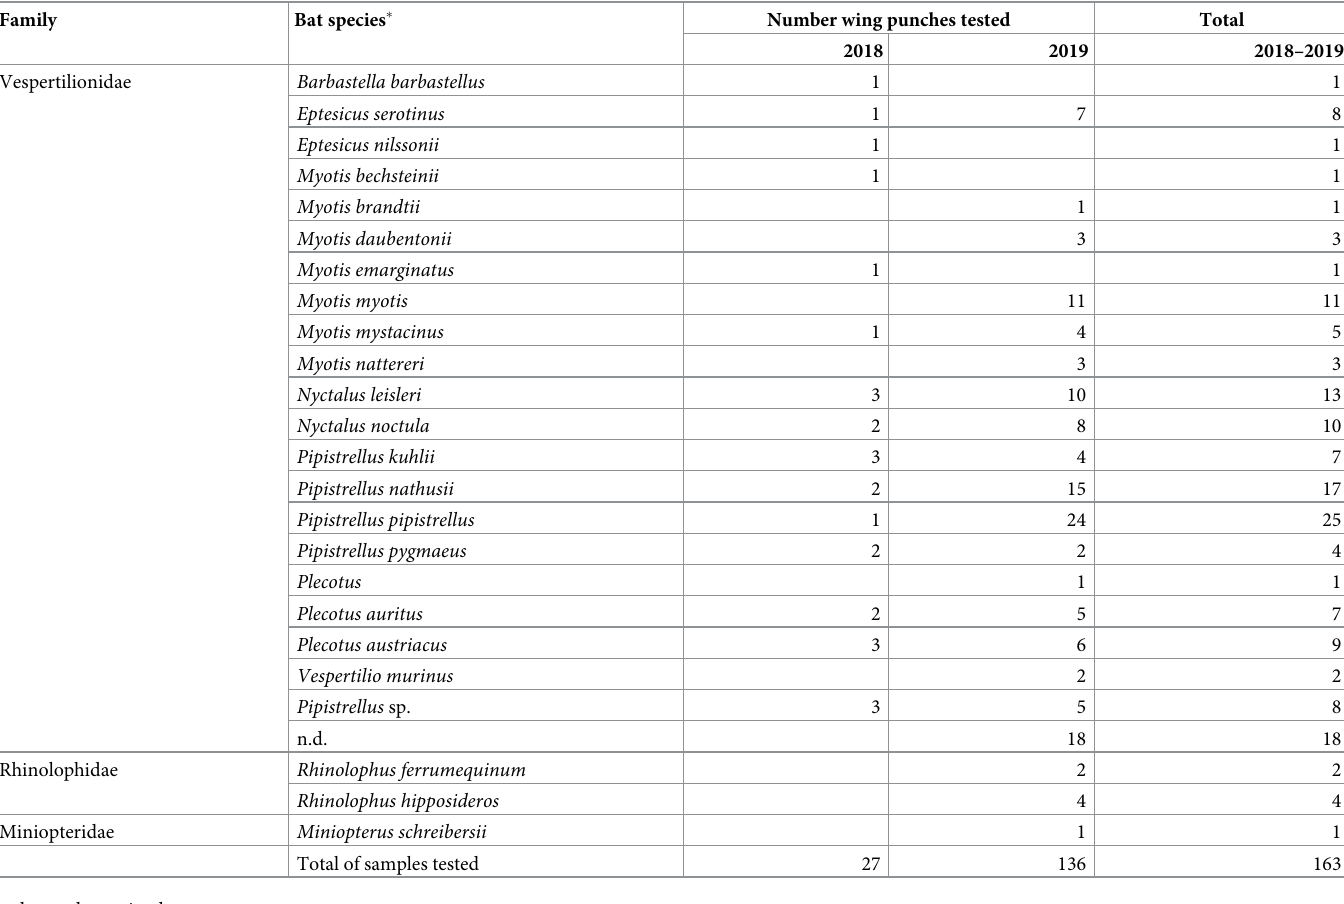
Table 1. Characteristics of the 163 bat carcasses included for genetic identification.